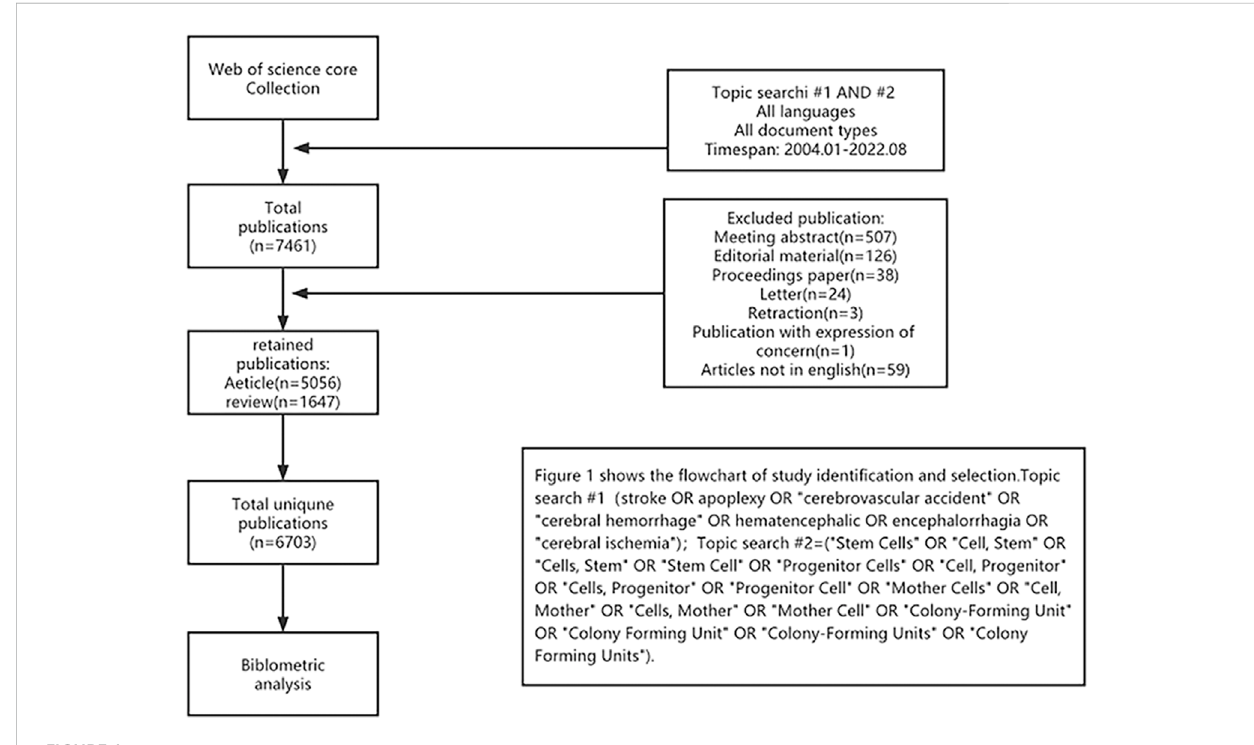
FIGURE 1 Flow chart of the screening process for research on stem cells in stroke.